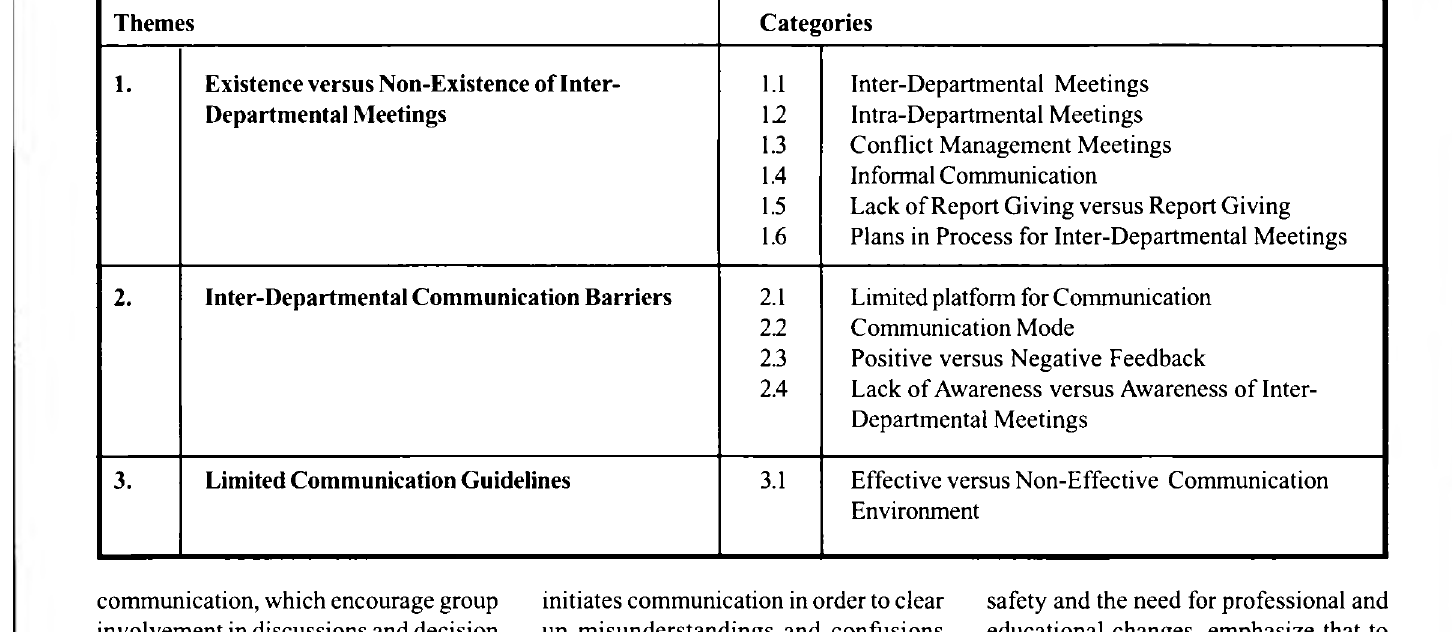
Table 1: Identified Themes and Categories of Inter-Departmental Communication